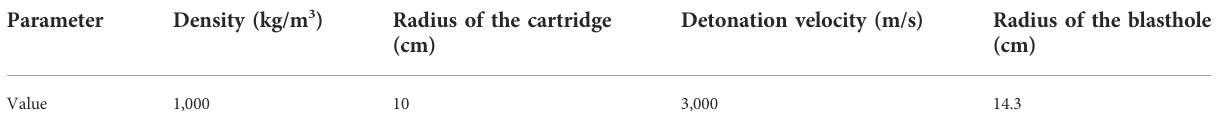
TABLE 2 Main technical indicators of